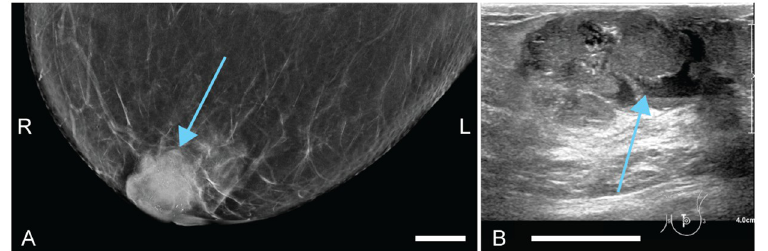
Fig 7. Case 3: Diagnostic images of a mucinous carcinoma in the left breast. L and R indicate left and right, respectively. (A) Craniocaudal x-ray (CC-MMG). (B) Ultrasound (US) image. All scale bars represent 20 mm.